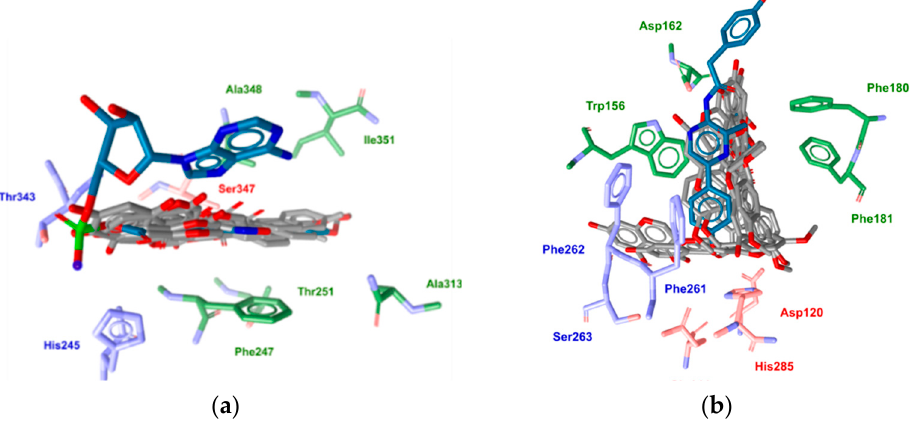
Figure 4. Comparisons of the ensembles of docking solutions obtained for biochanin A for the firefly luciferase (PDB: 3IES) ( a ) and Renilla luciferase (PDB: 2PSJ) ( b ) binding sites.